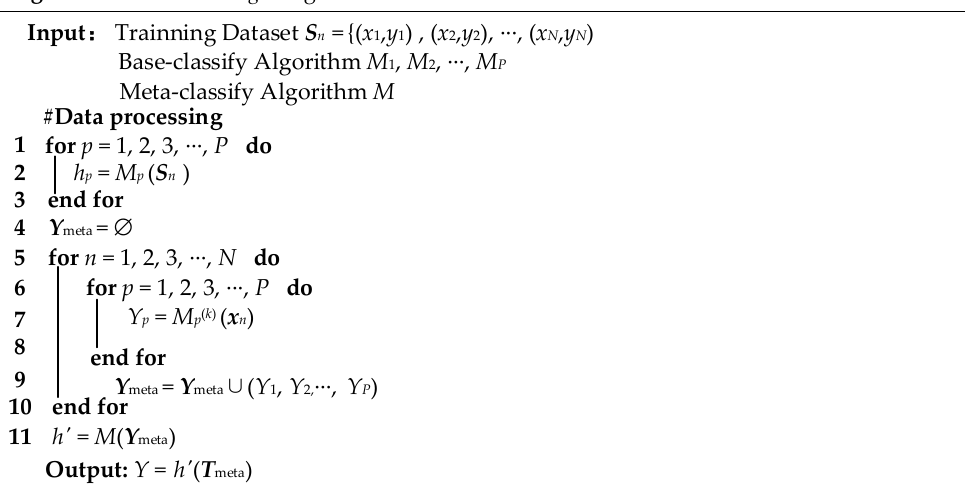
Algorithm 1: The stacking integrated structure Algorithm 1. The stacking integrated